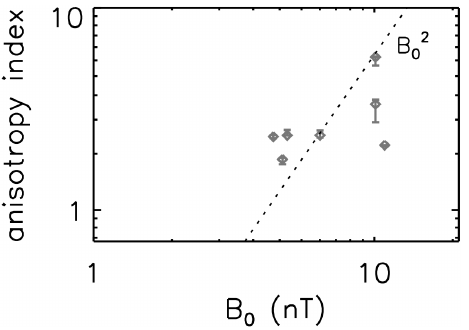
Figure 9. Anisotropy index plotted as a function of the mean mag- netic field magnitude as measured by the Cluster spacecraft in the solar wind. The dotted line is a scaling law (Eq. 5) predicted by Dastgeer and Zank (2003) for electron magnetohydrodynamic tur-